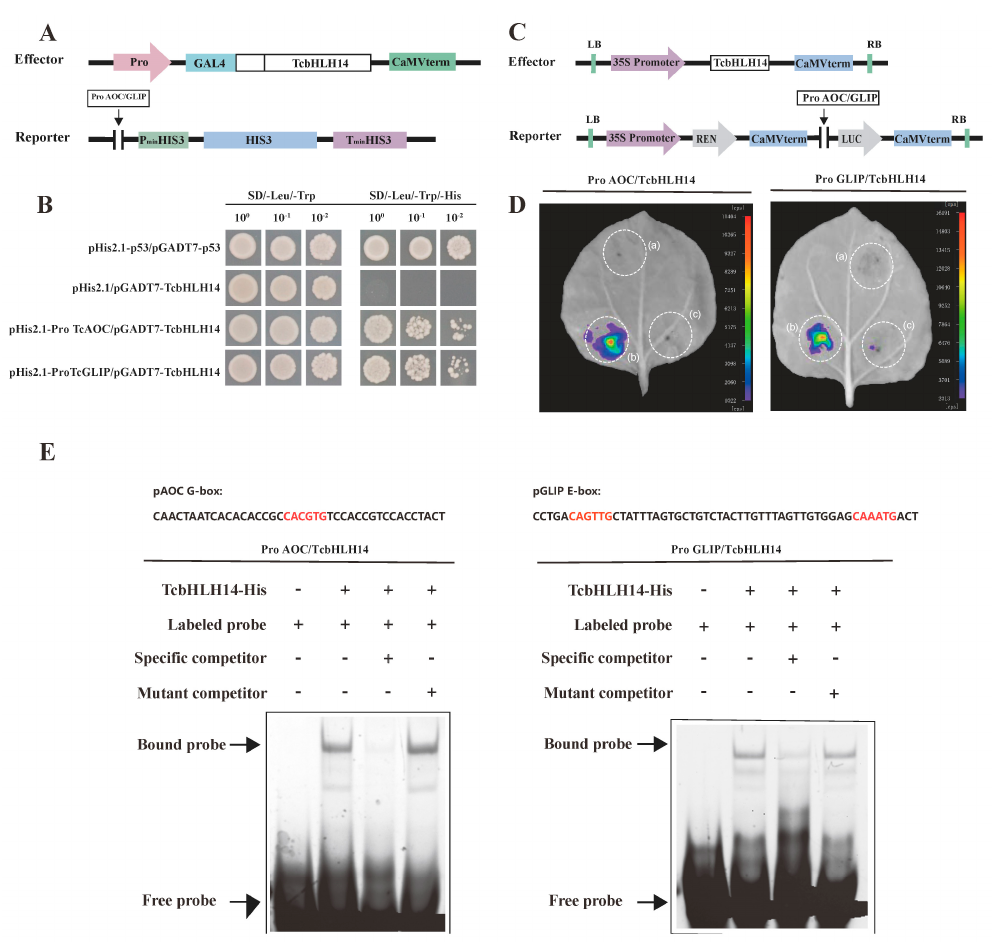
Figure 4. TcbHLH14 directly binds to the promoters of TcAOC and TcGLIP . ( A ) Diagram of